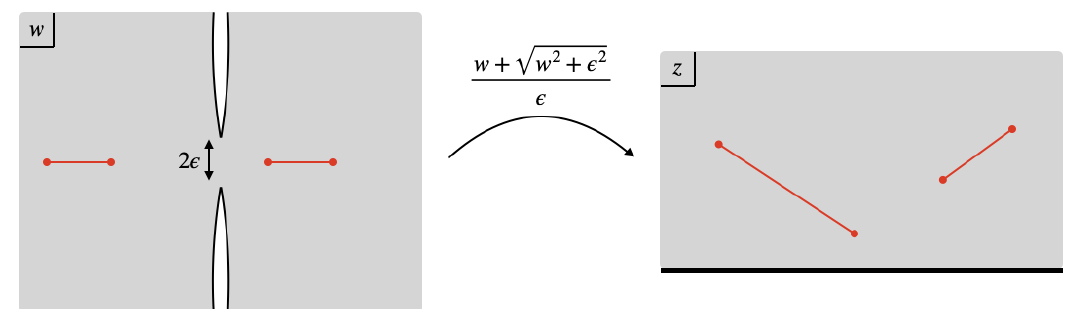
Figure 7 . The path integral to prepare the initial state of the local joining quench is shown on the left. We exaggerate the size of the cuts on the imaginary axis. The boundaries on these cuts get mapped to the real axis after applying